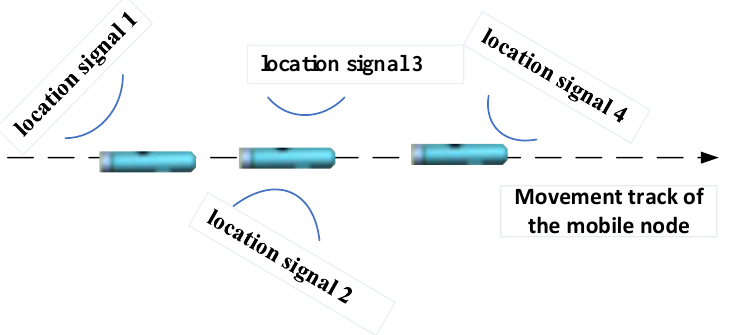
Figure 3. The schematic diagram of asynchronous sampling of the mobile node detection location signals. This paper uses time-delay calculation to calibrate the location signal arrival time.